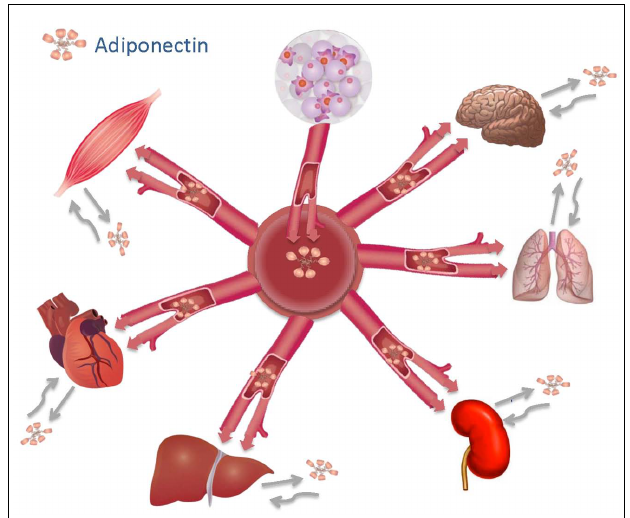
FIGURE 2 | Endocrine and autocrine/paracrine effects of adiponectin. The figure indicates that adiponectin in circulation (blood vessel, center) is derived primarily from adipose tissue (top). Circulating adiponectin can travel to numerous tissues and mediate endocrine effects. In addition, several tissues can also produce adiponectin (solid gray arrow) which can then act locally (twisted gray arrow) to mediate functional autocrine or paracrine